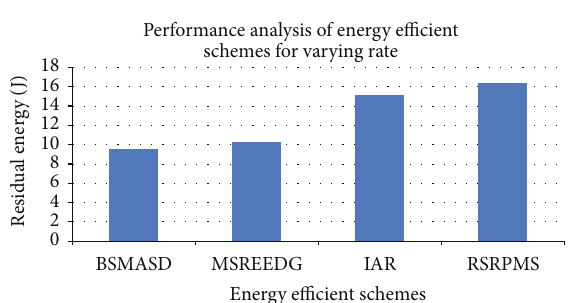
Figure 9: Data rate versus drop in terms of sink.